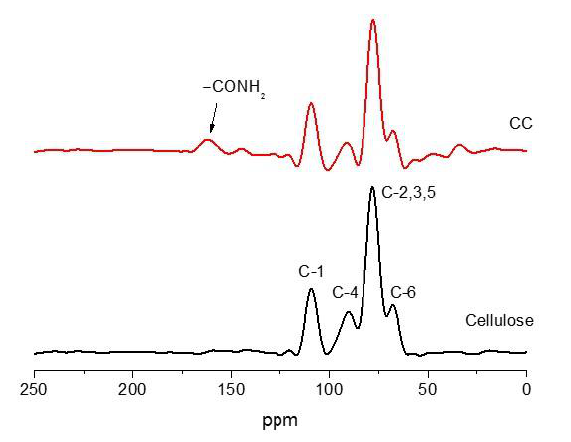
Figure 3. Solid-state 13 C-NMR spectra of cellulose and cellulose carbamate (DS = 0.123).